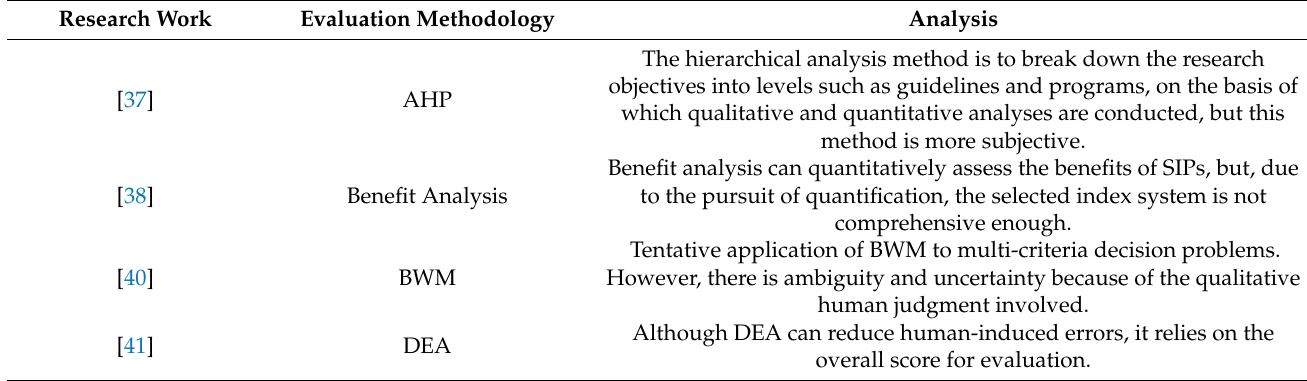
Table 1. Smart industrial park intelligence level dimension